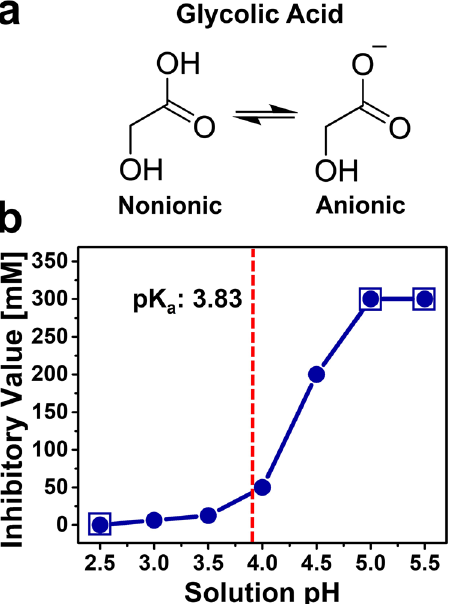
Figure 1. Evaluation of glycolic acid as an antibacterial agent to inhibit C. acnes viability. ( a ) Molecular structure of glycolic acid in the nonionic (protonated) and anionic (deprotonated) states. The equilibrium ratio of glycolic acid molecules in the two states depends on the pH condition. (b) Experimentally determined lowest concentration of glycolic acid to fully inhibit C. acnes viability in different pH conditions. The C. acnes cell concentration was 1 × 10 6 CFU mL − 1 and cell suspensions were incubated in glycolic acid solutions at different pH conditions for 1 hr before agar plating to determine if glycolic acid treatment inhibited cell viability. Each data point is representative of three independent experiments. The boxed-in circles indicate pH conditions where an inhibitory concentration was not recorded for one of two reasons: the pH condition itself during the incubation step caused loss of C. acnes viability (pH 2.5) or glycolic acid was inactive ( i.e ., not antibacterial) within the test range up to 200 mM (pH 5.0 and 5.5). The dashed vertical line represents the pK a value of glycolic acid, which is around pH